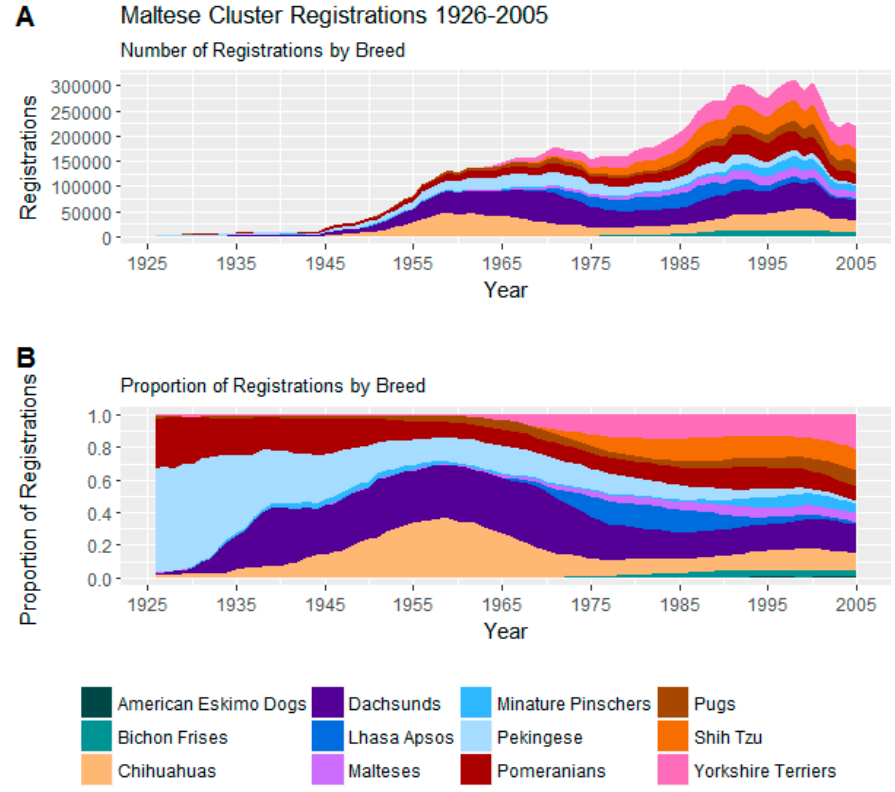
Figure 3. ( A ) Number of registrations; ( B ) and proportion of registrations within the Maltese